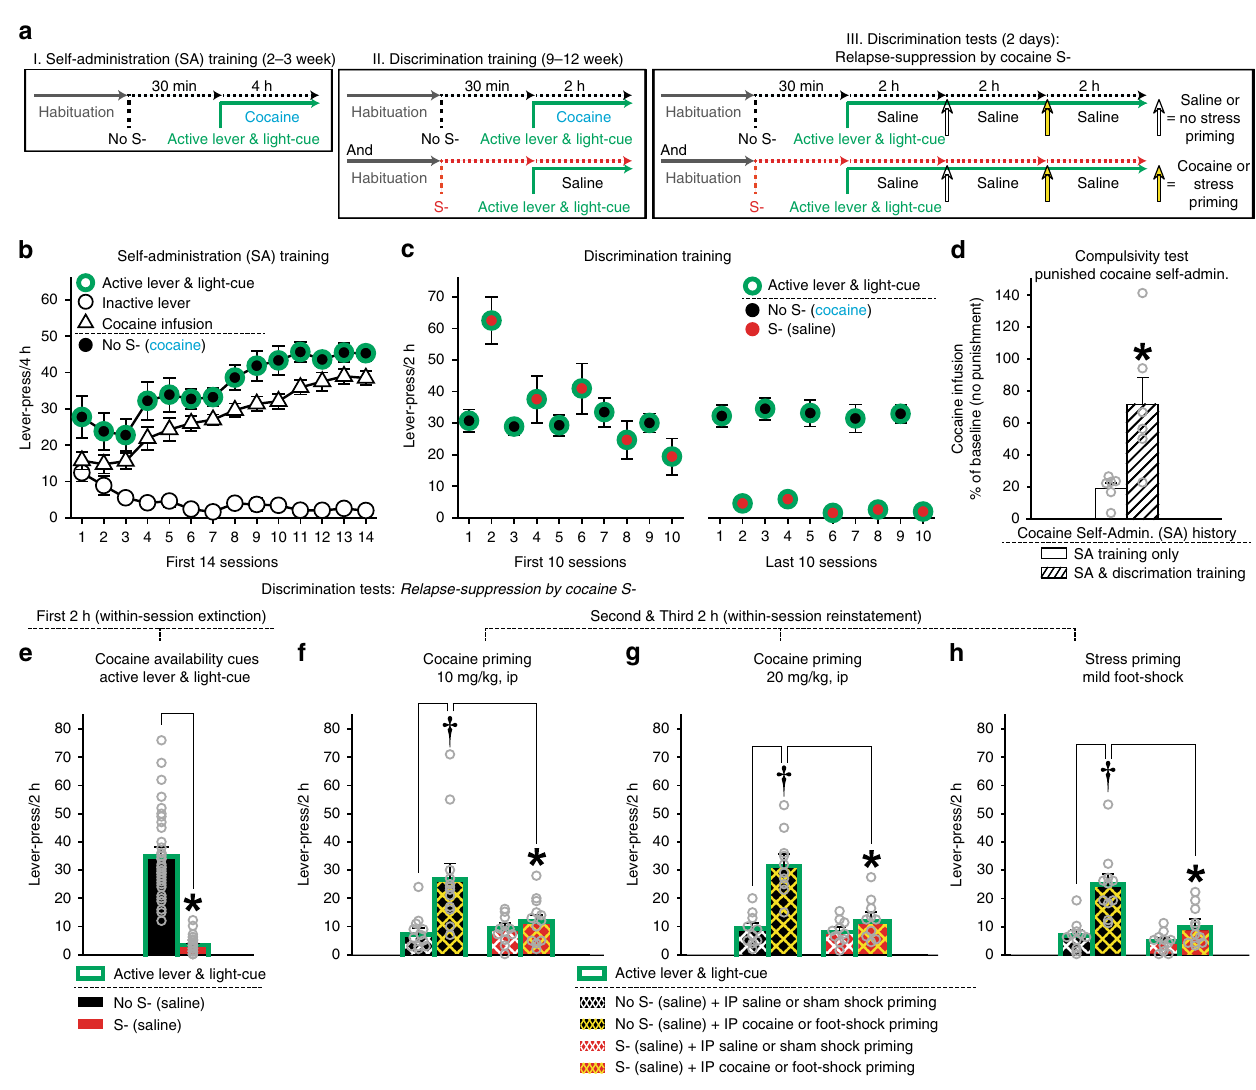
Fig. 1 Omission cue-induced suppression (OCIS) procedure for cocaine seeking. A total of 63 rats were initially used and randomly assigned to four experimental groups: Compulsivity test, Cocaine (1.0 or 2.0 mg/kg), and Stress priming groups ( n = 14,16,16,17). Of which, 45 rats were retained for statistical analyses (see Methods). Final Ns for each group are described below. All data are mean and SEM. Gray open circles on bar charts depict individual data-points. a Timeline and schedule. b Responses during the fi rst 14 days of Self-administration (SA) training. c Responses during the fi rst and last 10 days of Discrimination training. d Compulsivity tests for animals ’ resistance to cocaine-paired punishment after cocaine access through the SA training phase vs. both SA and Discrimination training phases. Each cocaine infusion was paired with an electric foot-shock (0.8 mA, 1-s). n = 6,6. Student ’ s t -test: t = 3.20, *P < 0.05. e Responses during the fi rst 2-h block of Discrimination test to determine cocaine S- ‘ s action against cocaine availability cues (10) (active lever and light-cue). n = 33. Paired t -test: t (32) = 11.50, *P < 0.001. Duplicate data-points from multiple subjects are not overlaid on this Figure for clarity because n = 33. Thus, these dot plots represent the data range. f , g Responses during the second and third 2 h-blocks of Discrimination test (within- session reinstatement) to determine cocaine S- ‘ s action against cocaine priming (10 and 20 mg/kg, IP). Two-way repeated measures ANOVA for the 10 mg/kg group ( n = 12): Priming ( F (1,11) = 19.20, P < 0.001) main effects and Cue-Test x Priming interaction ( F (1,11) = 10.34, P < 0.01). Two-way repeated measures ANOVA for the 20 mg/kg group ( n = 10): Cue-Test ( F (1,9) = 42.02, P < 0.001) and Priming ( F (1,9) = 47.19, P < 0.001) main effects, and Cue-Test x Priming interaction ( F (1,9) = 94.49, P < 0.001). † P < 0.001 vs. IP saline. * P < 0.01 – 0.05 vs. No S-. Tukey HSD test. h Responses during the second and third 2 h-blocks of Discrimination test to determine cocaine S- ‘ s action against stress priming (mild electric foot-shock, intermittent, 10 min, 0.8 mA). n = 11. Two-way repeated measures ANOVA: Cue-Test ( F (1,10) = 17.41, P < 0.01) and Priming ( F (1,10) = 121.79, P < 0.001) main effects, and Cue-Test x Priming interaction ( F (1,10) = 15.36, P < 0.01). † P < 0.01 vs. sham foot-shock. * P < 0.05 vs. No S-. Tukey HSD divided into three 2-h blocks. Under both No S- and S- Despite the extensive drug history linked to compulsive cocaine conditions, cocaine was not available for self-administration. intake 18,19 (Fig. 1d), cocaine S- suppressed the relapse-promoting action of cocaine availability cues (Fig. 1e). During the fi rst 2-h Relapse-suppression against cocaine availability cues (active lever block of the No S- test, the rats initiated and maintained active and light-cue) was determined in all rats during the fi rst 2-h lever-pressing, even though this behavior only resulted in the block. Relapse-suppression against cocaine and stress priming light-cue but not cocaine. In contrast, during the S- test, the same was determined in different groups of rats during the second and rats minimally lever-pressed under otherwise identical stimulus third 2-h blocks.